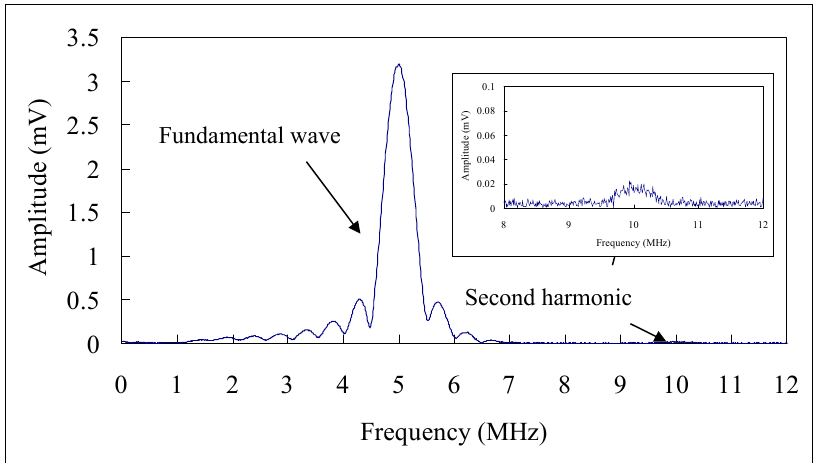
Figure 3. The sketch of the experimental setup for nonlinear ultrasonic measurement.